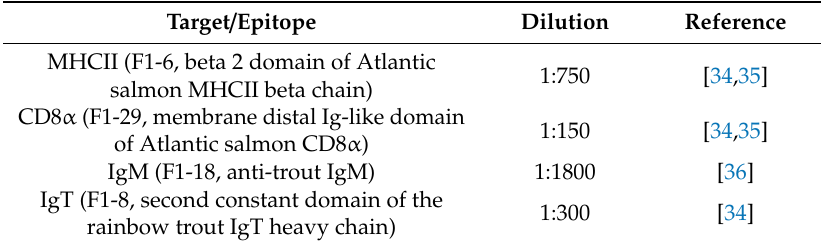
Table 3. Monoclonal antibodies used in the present